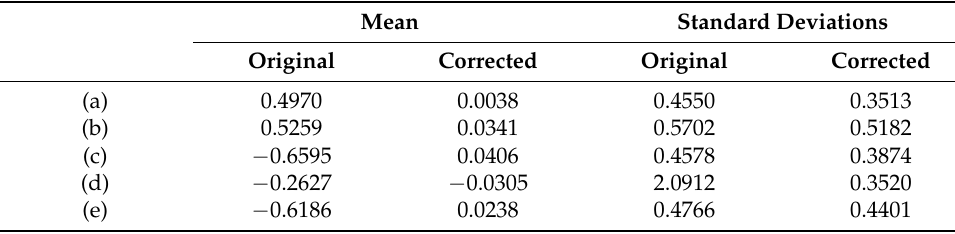
Table 3. Statistics of the phase before and after the systematic error correction of five typical interfero- metric